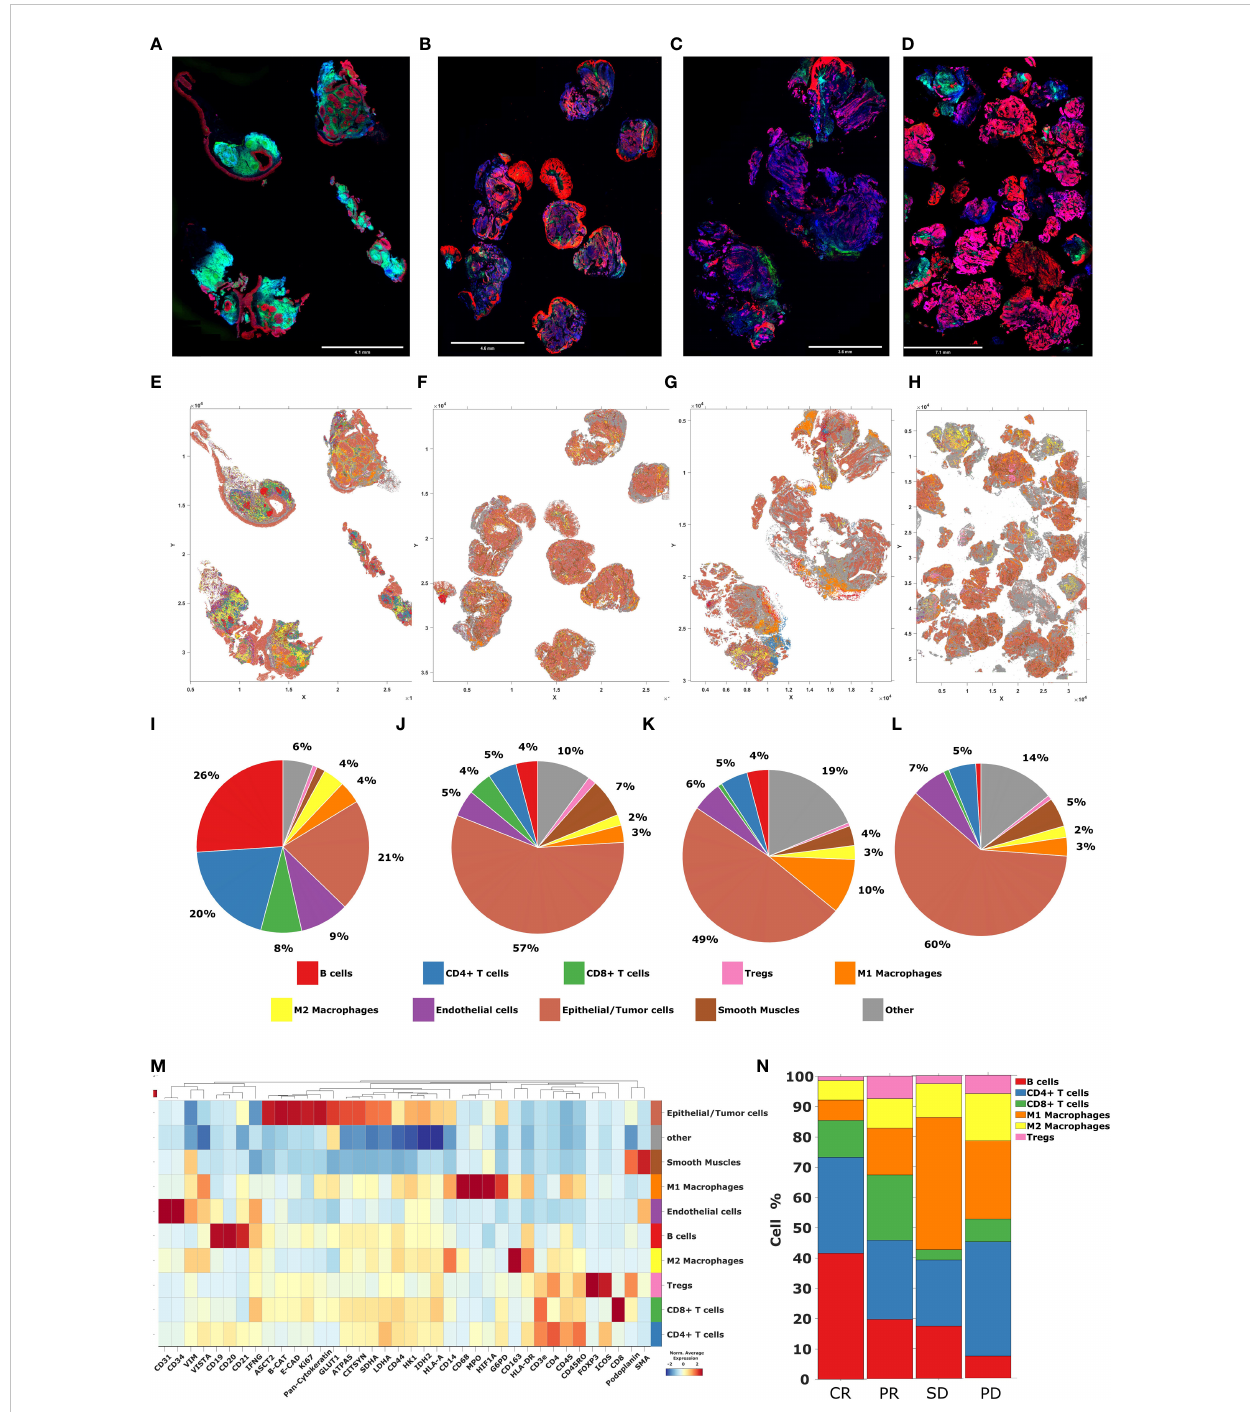
FIGURE 9 Cell phenotyping by Akoya PhenoCycler-Fusion. (A – D) High plex immuno fl uorescence (mIF) whole slide tissue images of patients with CR, PR, SD, and PD, from left to right respectively. Blue = DAPI, Green = CD45, Pink = E-cadherin, Red = panCK (E – H) Tissue maps of patients with CR, PR, SD, and PD, from left to right respectively. (I – L) The pie charts representing the abundance of distinct phenotype clusters sorted by color across tissue samples from patients with CR, PR, SD, and PD, from left to right respectively. (M) The heatmap including a curated clustering dendogram with cell types. (N) The bar chart representing cell type composition as well as the intra-tumor heterogeneity across tissue samples from patients with CR, PR, SD, and PD, from left to right